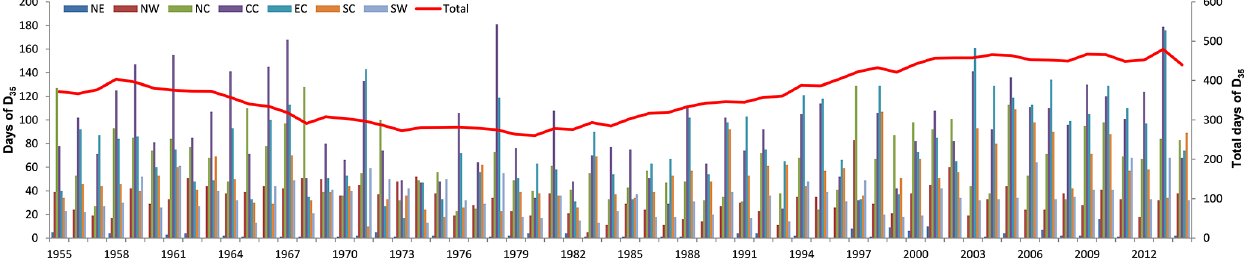
Figure 4. Time series of D 35 in different climate zones of China from 1955 to